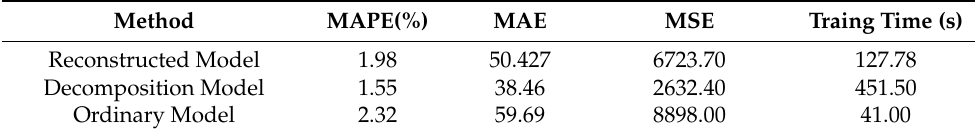
Table 5. Comparison of the reconstructed model and the decomposition model.